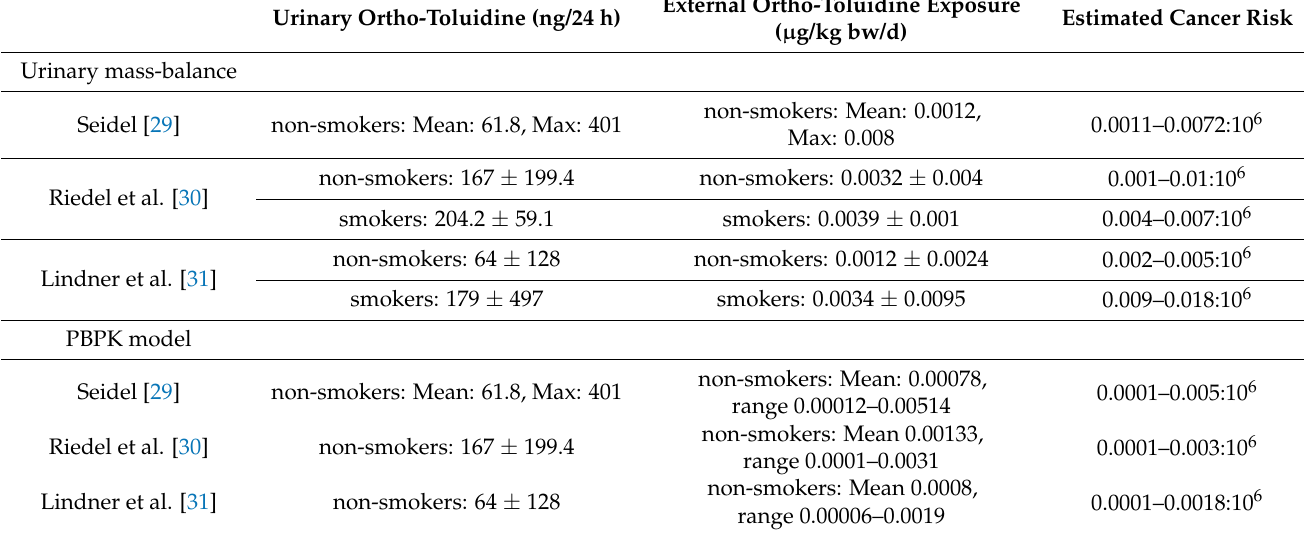
Table 6. Estimated lifetime cancer risk values of o-toluidine for the general population using a urinary mass-balance method and a PBPK model in INTEGRA. External Ortho-Toluidine Exposure Urinary Ortho-Toluidine (ng/24 h) Estimated Cancer ( µ g/kg bw/d)